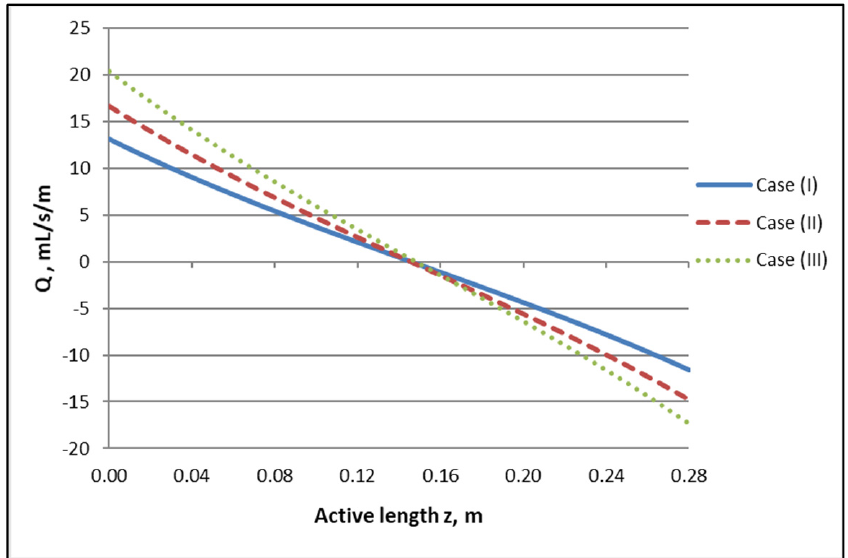
Figure 5. Determined axial variation of local trans-membrane flow rate per unit of length, Q, for the three studied cases. Case (I): Q Blood /Q Dialysate : 200/300 mL/min. Case (II): Q Blood /Q Dialysate : 250/400 mL/min. Case (III): Q Blood /Q Dialysate : 300/500 mL/min.